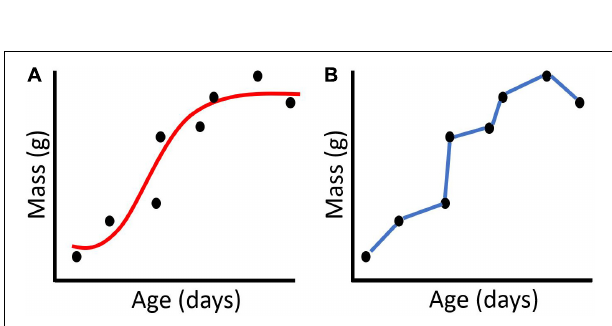
FIGURE 2 | Hypothetical example of a (A) function-valued trait approach and a (B) character-state approach for modeling a chick growth